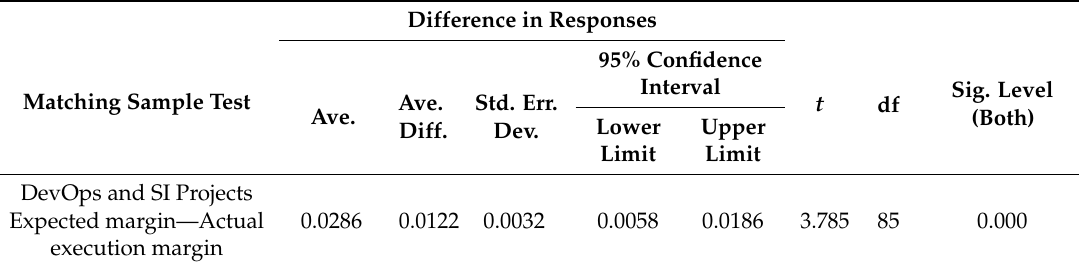
Table 10. Verification of matching samples (expected profit margin—actual execution profit margin).